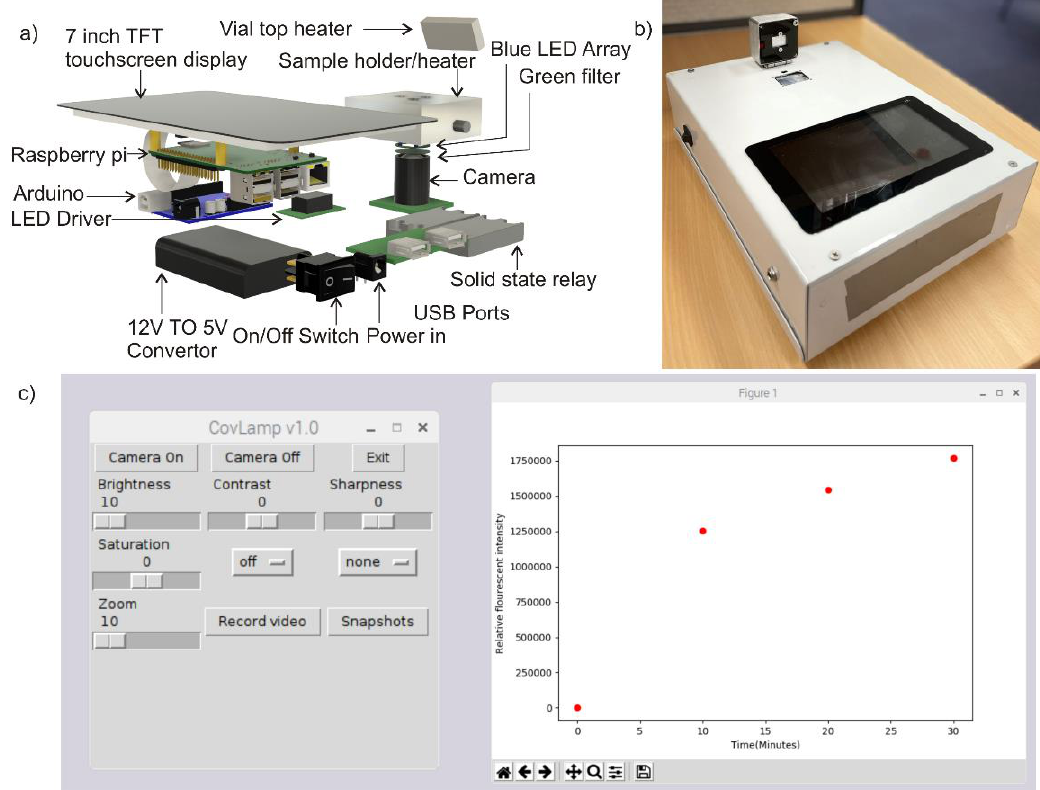
Figure 3. ( a ) Exploded view of the portable device. ( b ) Photograph of the portable device. ( c ) Screenshot of the graphical user interface.